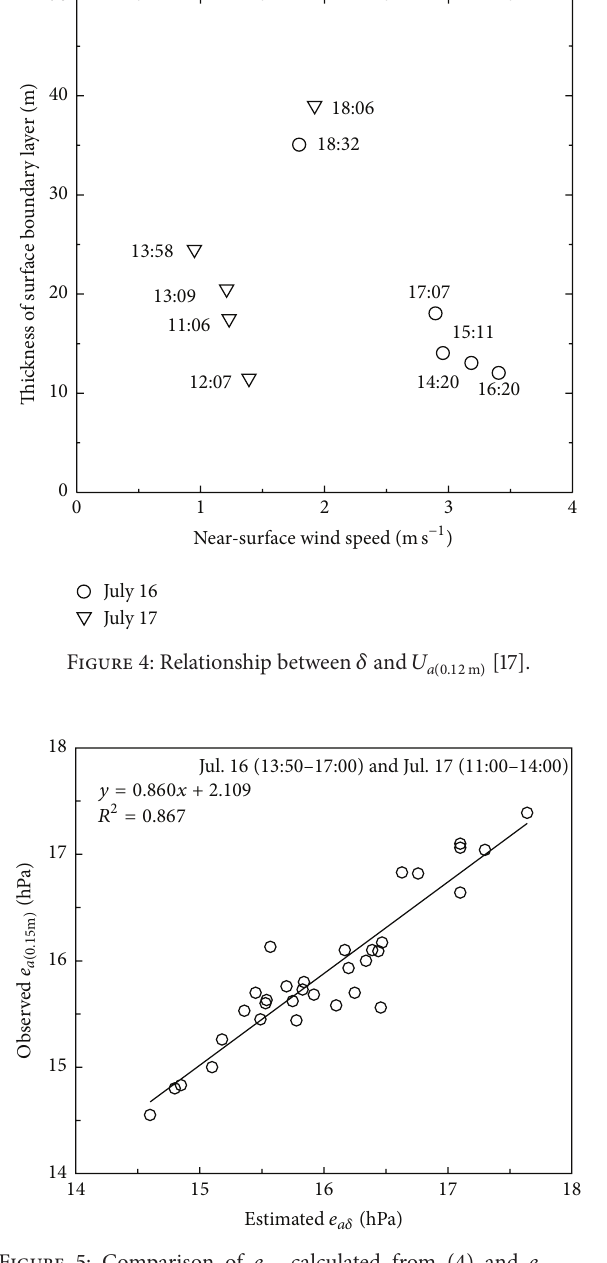
Figure 5: Comparison of 𝑒 𝑎𝛿 calculated from (4) and 𝑒 𝑎(0.15 m ) measured in the field [17].